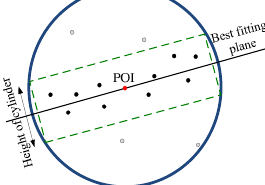
Figure 4: Adaptive cylinder